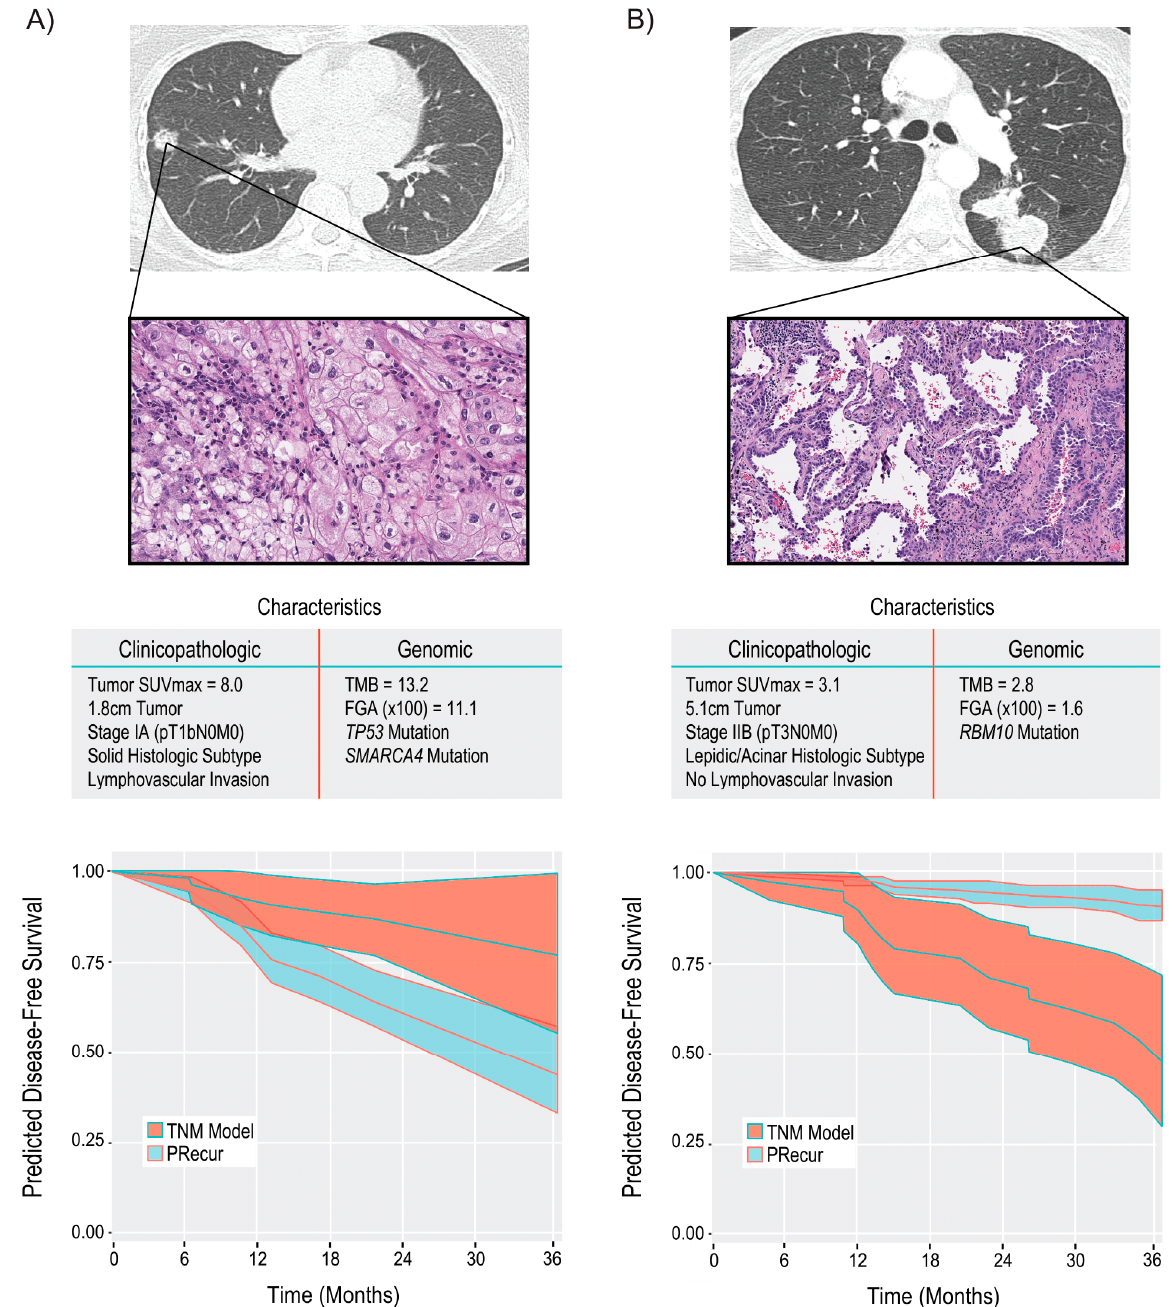
Figure 5. Computational machine-learning prediction model (PRecur) for disease-free survival applied to two patient scenarios. ( A ) Patient with a small, 1.8-cm tumor (pT1bN0M0, stage IA). Three-year disease-free survival curves were predicted by PRecur versus the tumor-node-metastasis model for all patients with pT1bN0M0 disease in our cohort ( n = 136). ( B ) Patient with a large, 5.1-cm tumor (pT3N0M0, stage IIB). Three-year disease-free survival curves were predicted by PRecur versus the tumor-node-metastasis model for all patients with pT3N0M0 disease in our cohort ( n = 53). FGA, fraction of genome altered; TMB, tumor mutation burden. (From JAMA Surgery , Jones, G.D.; Brandt, W.S.; Shen, R.; Sanchez-Vega, F.; Tan, K.S.; Martin, A.; Zhou, J.; Berger, M.; Solit, D.B.; Schultz, N., “A genomic-pathologic annotated risk model to predict recurrence in early-stage lung adenocarcinoma.” Vol. 156, e205601–e205601. Copyright © (2021) American Medical Association. Reprinted with permission).